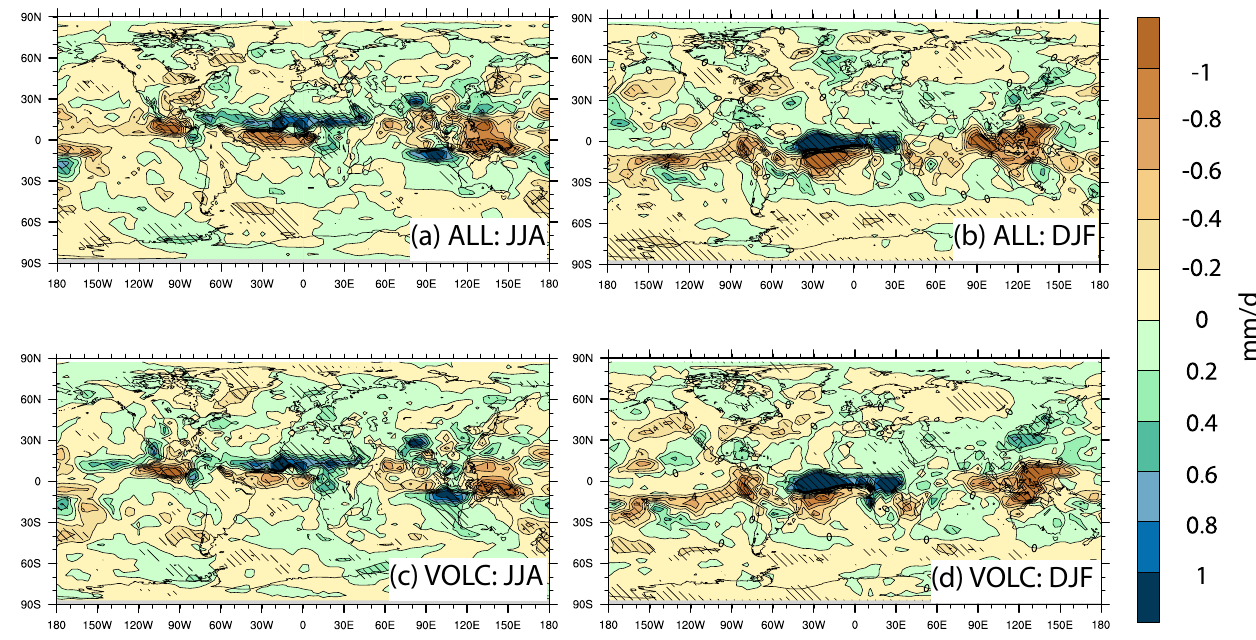
Fig. 7. (a) Ensemble mean of precipitation anomalies, averaged over the 1805–1825 period for the ALL run, JJA season. (b) Same for the DJF season. (c) Same for the VOLC run, JJA season. (d) Same for the VOLC run, DJF season. For all plots, dashed areas show significant changes in a 10% t